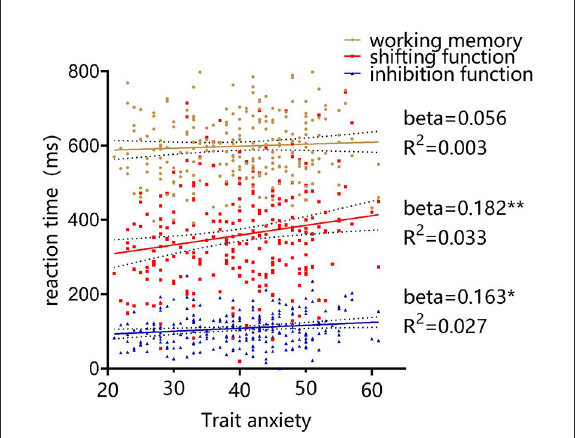
FIGURE4 The relationship between trait anxiety and executive functions in college students. P < 0.05, P < 0.01 and P < 0.001 were marked with “*,” “**” and “***,” all representing differences with statistical significance.